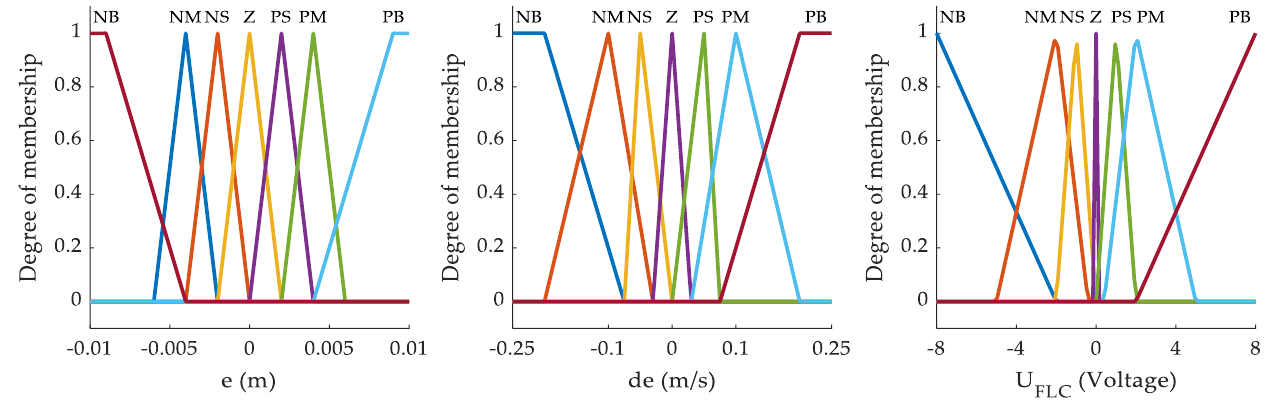
Figure 5. Membership functions of FLC for valve control. Table 2. Rule table of FLC for valve.